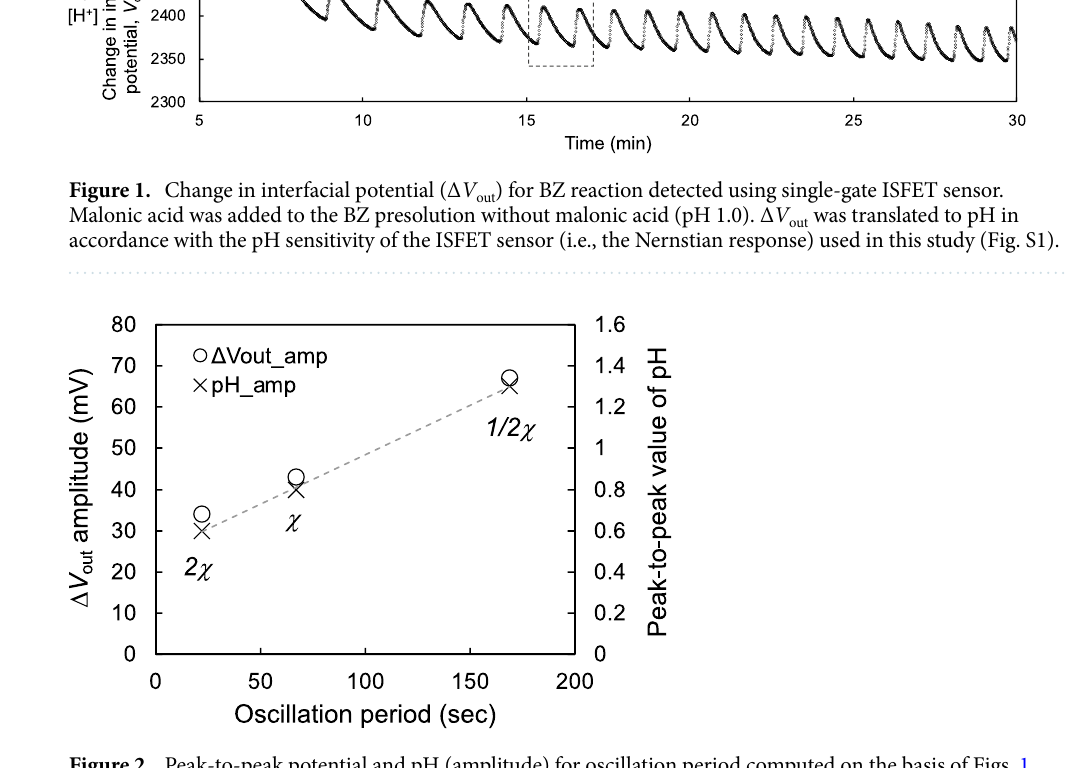
Figure 2. Peak-to-peak potential and pH (amplitude) for oscillation period computed on the basis of Figs. 1 and S2. The concentration χ of the BZ solution was controlled to 1/2 χ , χ , and 2 χ . The oscillation periods, Δ V out , and ΔpH were averaged in the limited range of about 5 min. Each standard error shows < 0.3 s for the oscillation periods, < 0.5 mV for Δ V out , and < 0.01 for